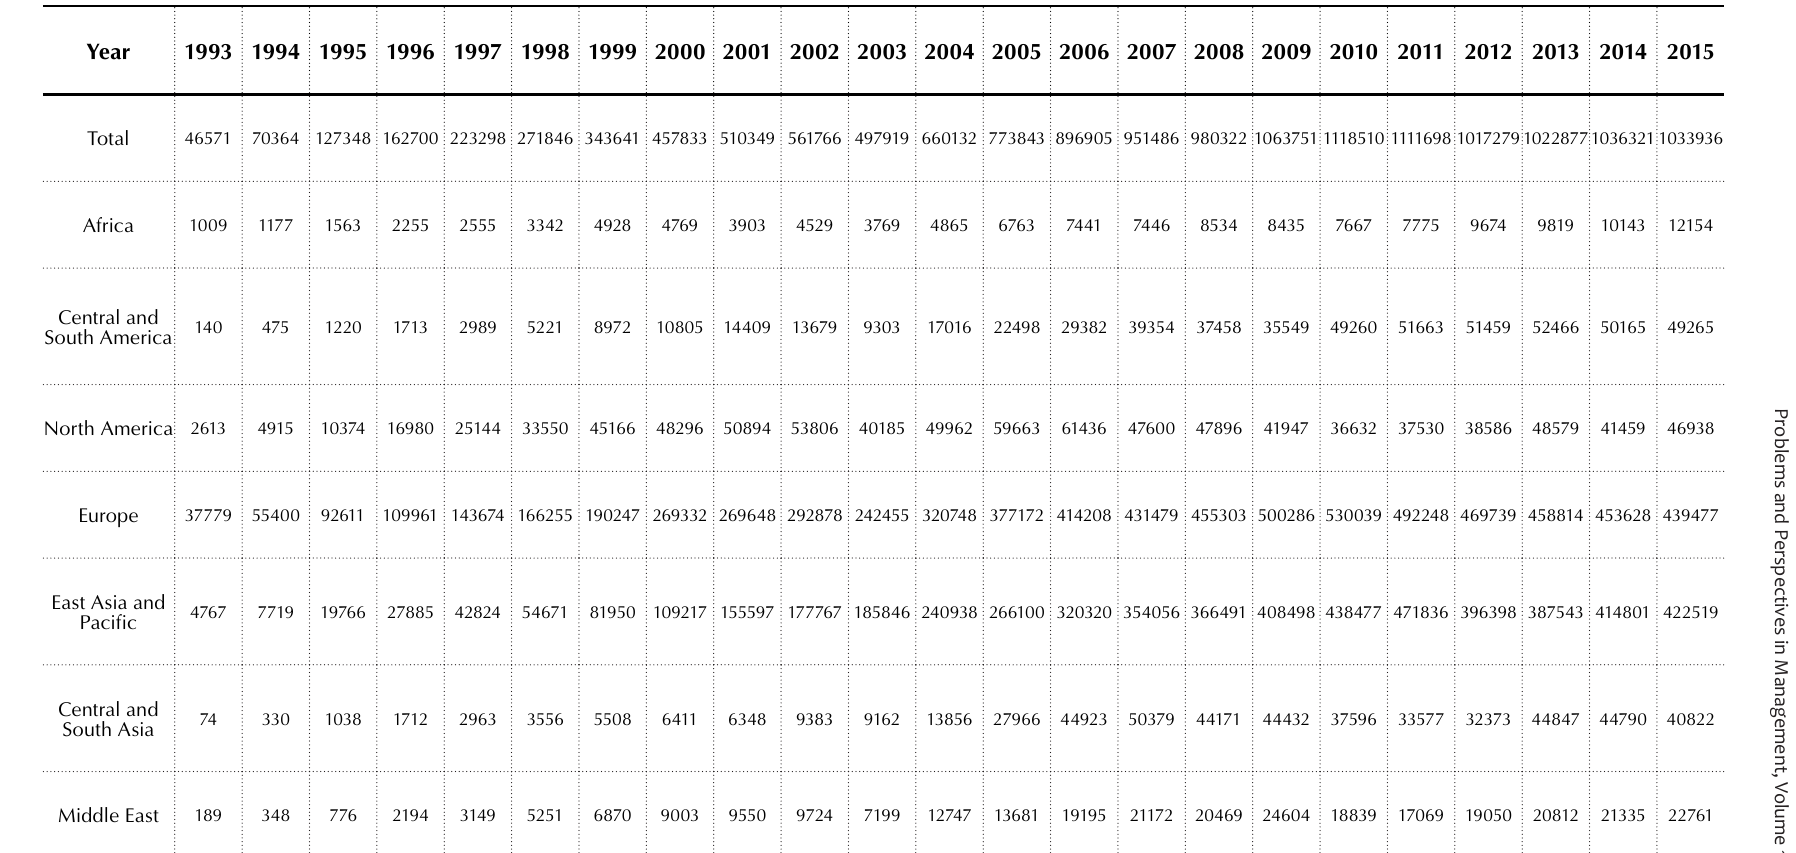
Table 1. The number of the registered certificates by